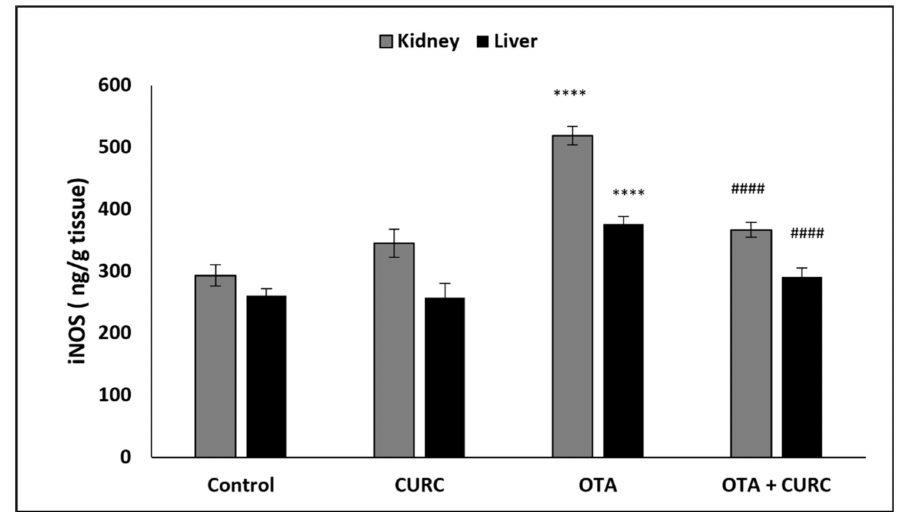
Figure 3. The antioxidant effect of curcumin (CURC) on kidney and liver inducible nitric oxide synthase (iNOS) activity in different experimental groups after 14 days of treatment. Control group; CURC group (100 mg/kg b.w. of CURC); OTA group (0.5 mg/kg b.w. of OTA); OTA + CURC group (0.5 mg/kg b.w. of OTA plus 100 mg/kg b.w. of CURC). Data are expressed as mean ± standard deviation (SD) of n = 6 rats in each group (**** p < 0.0001 vs. Control; #### p < 0.0001 vs. OTA).